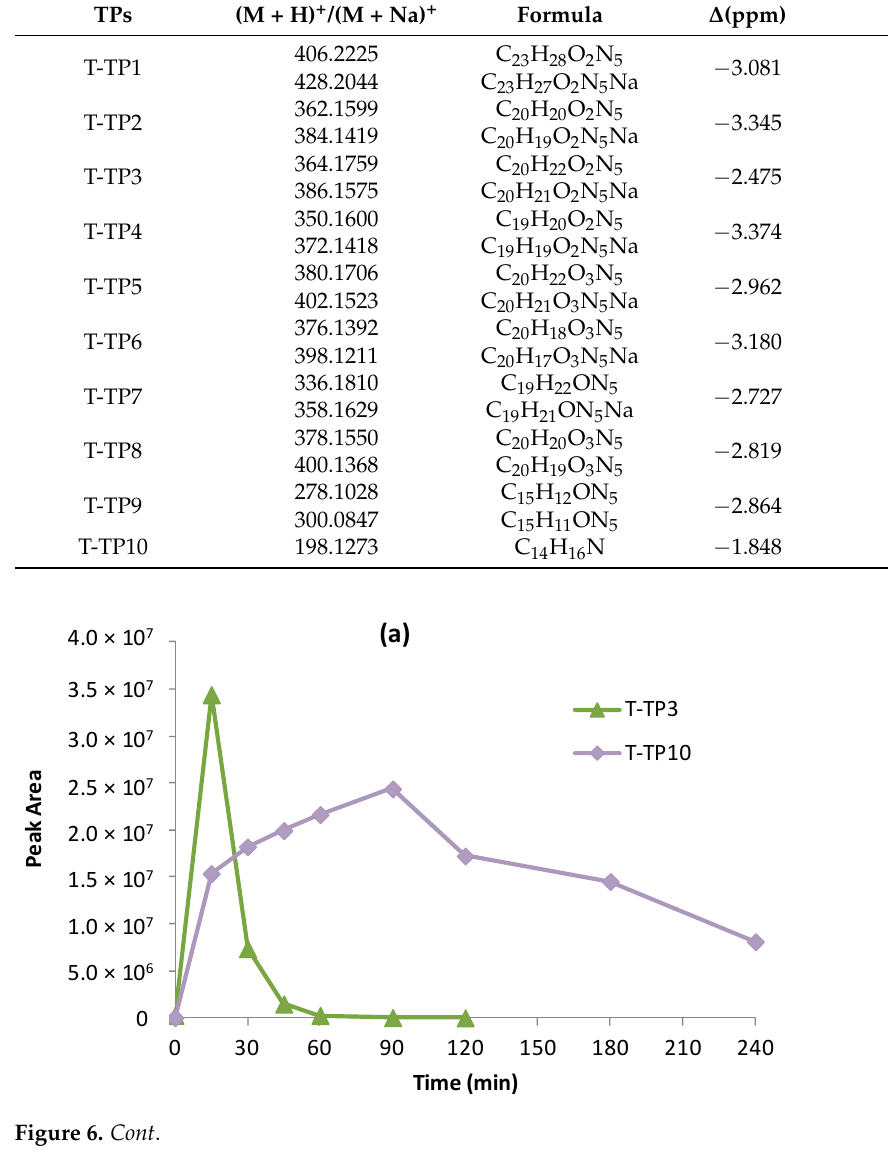
Figure 6. Evolution profiles of major ( a ) and minor ( b ) VLS TPs by TiO 2 photocatalytic oxidation process. Based on the structure assignments and TPs evolution profiles, the tentative trans- formation pathways are summarized in Figure 7. In conclusion, the VLS TiO 2 photocata- lytic degradation process followed four major pathways (Figure 7): (a) N-lateral chain ox- idation; (b) cyclization; (c) hydroxylation; and (d) cleavage of the amide bond. Two main differences can be noted compared to the g-C 3 N 4 process., i.e., the presence of cyclization TPs and the absence of hydroxy-derivatives of VLS.